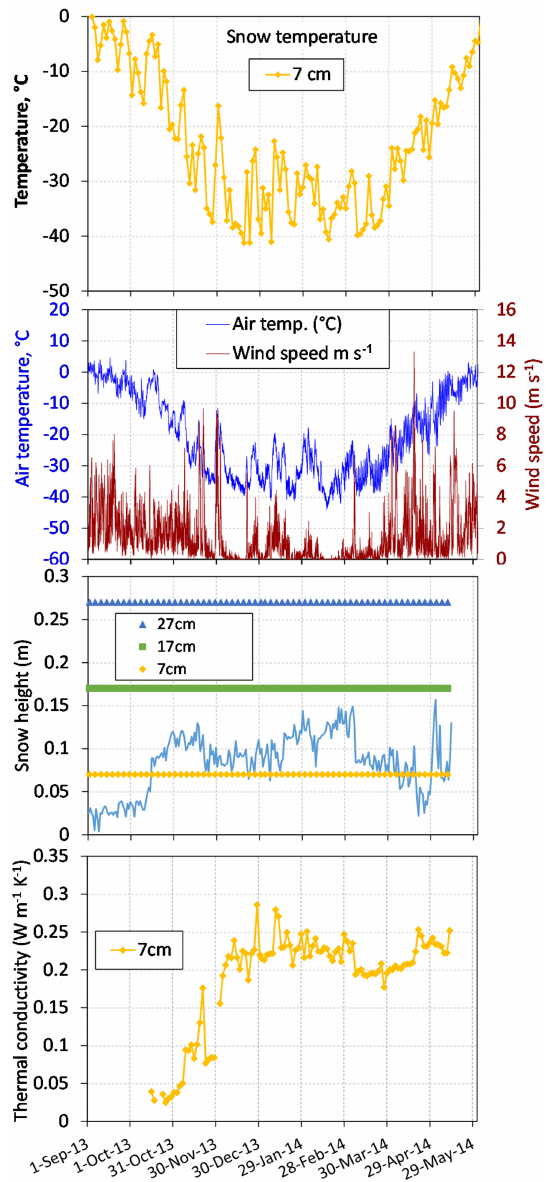
Figure 6. Snow temperature, air temperature, wind speed, snow height and snow thermal conductivity at 7cm height during the 2013–2014 winter season at Bylot Island. The levels of the three thermal conductivity needle probes (NPs) are indicated in the snow height panel, showing that only the lowermost NP was